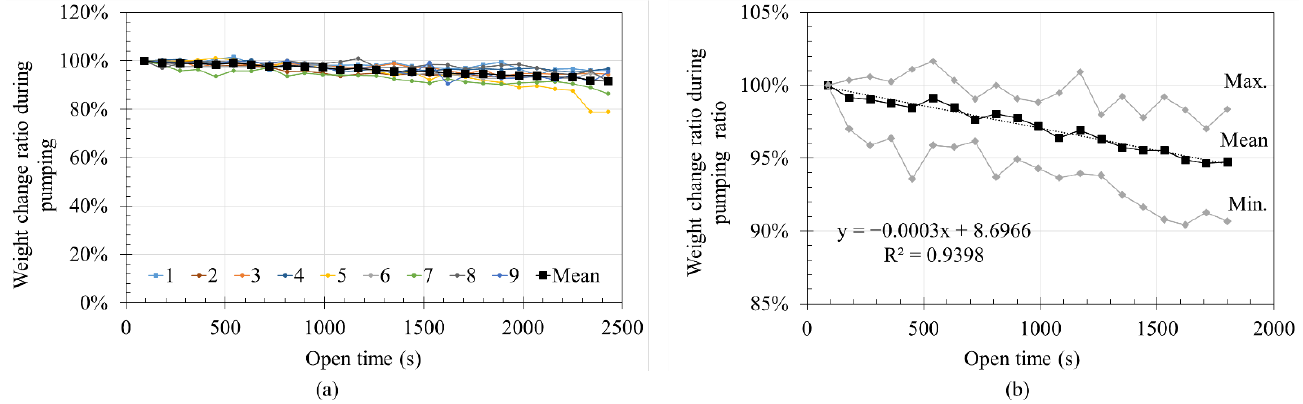
Figure 11. Weight decreasing ratio during pumping: ( a ) weight change ratio of pumped mortar; ( b ) mean weight change ratio and standard deviation of pumped mortar.